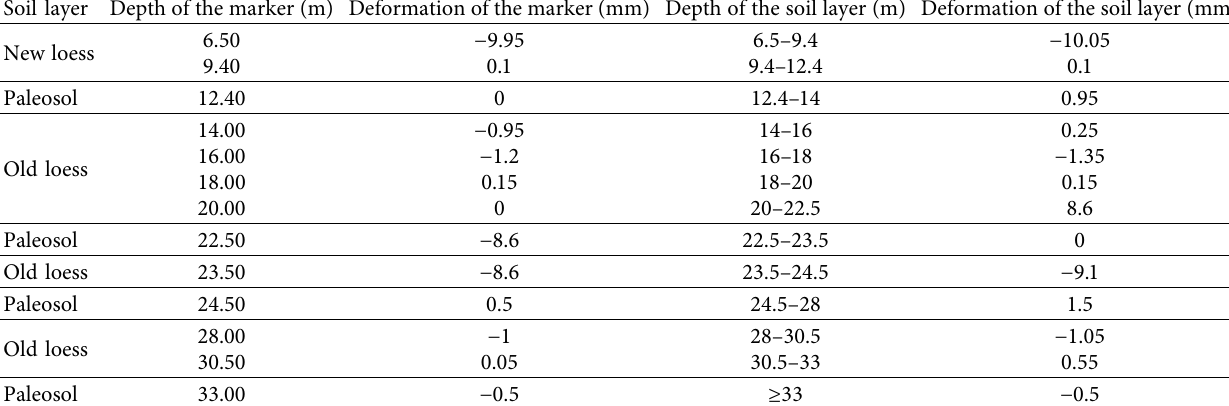
Table 3: Calculation table of deep subsidence of deep